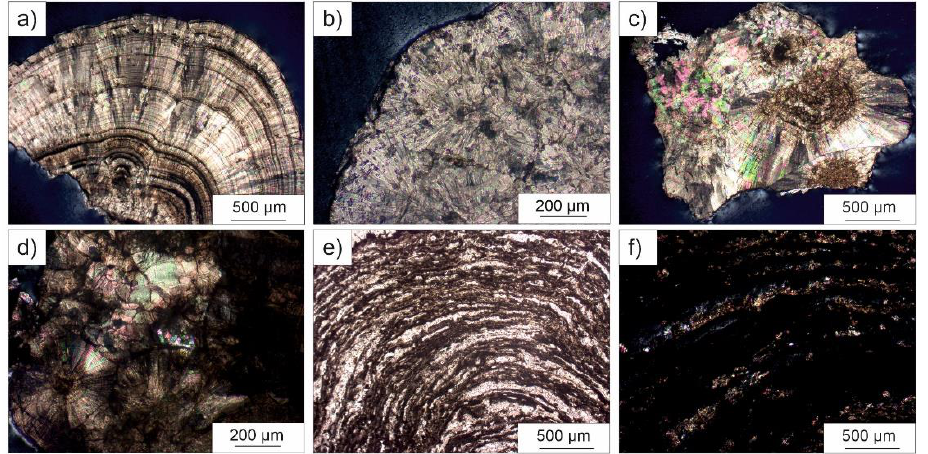
Figure 2. Micrographs of urinary stones captured in polarized light microscopy: ( a ) compact radiating and concentric internal structure in CaOx kidney stone KS026 subtype Ia (crossed polars, CP); ( b ) compact unorganized internal structure of subtype Ib sample (KS014, CP); ( c ) unorganized internal structure of CaOx sample KS031; ( d ) subtype IIb sample (KS013) with residual organic matter; ( e , f ) loose concentric layers of carbonated apatite and CaOx in sample KS008 (subtype IVa1), in plane and crossed polars, respectively.